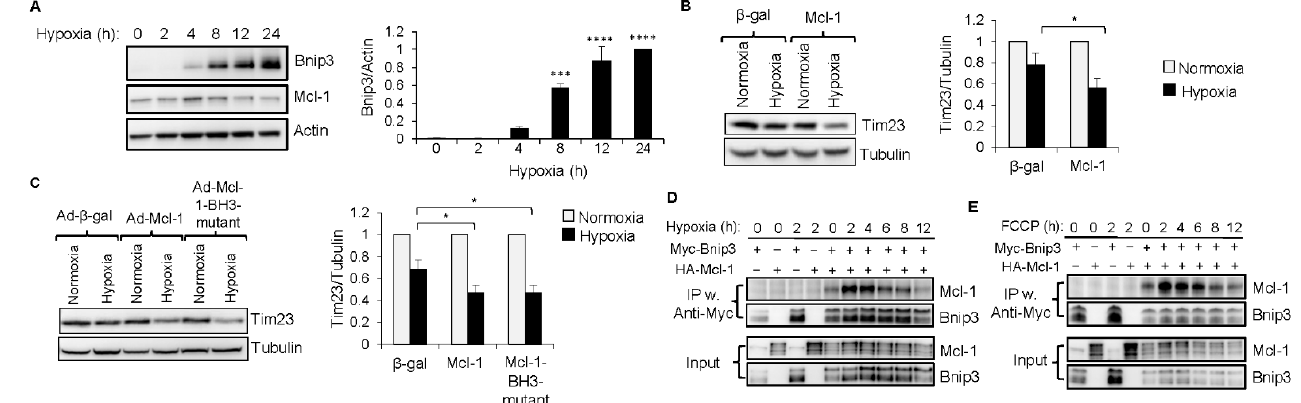
Figure 6. Mcl-1 overexpression enhances hypoxia-mediated mitophagy. ( A ) Representative blot of endogenous Bnip3 and Mcl-1 and quantification of Bnip3 in MEFs exposed to hypoxia for up to 24 h ( n = 3). ( B ) Representative Western blot and quantification of Tim23 in normoxic and hypoxic cells overexpressing either β -gal or Mcl-1 ( n = 3). ( C ) Representative Western blot and quantification of Tim23 in normoxic and hypoxic cells overexpressing β -gal, Mcl-1, or the Mcl-1 BH3-mutant ( n = 3). ( D ) Coimmunoprecipitation of Bnip3 using anti-Myc in MEFs overexpressing Bnip3 and Mcl-1, followed by Western blotting for Bnip3 and Mcl-1 in the IP and cell lysates (input). Cells were cultured under hypoxic conditions for the indicated time points. ( E ) Coimmunoprecipitation (IP) of Bnip3 using anti-Myc in MEFs overexpressing Bnip3 and Mcl-1, followed by Western blotting for Bnip3 and Mcl-1 in the IP and total cell lysates (input). Cells were treated with 25 μ M FCCP for the indicated time points. * p < 0.05, *** p < 0.001, **** p < 0.0001. Data are mean ± SEM. Statistical test: ANOVA, followed by Dunnett’s or Bonferroni’s multiple comparison test.